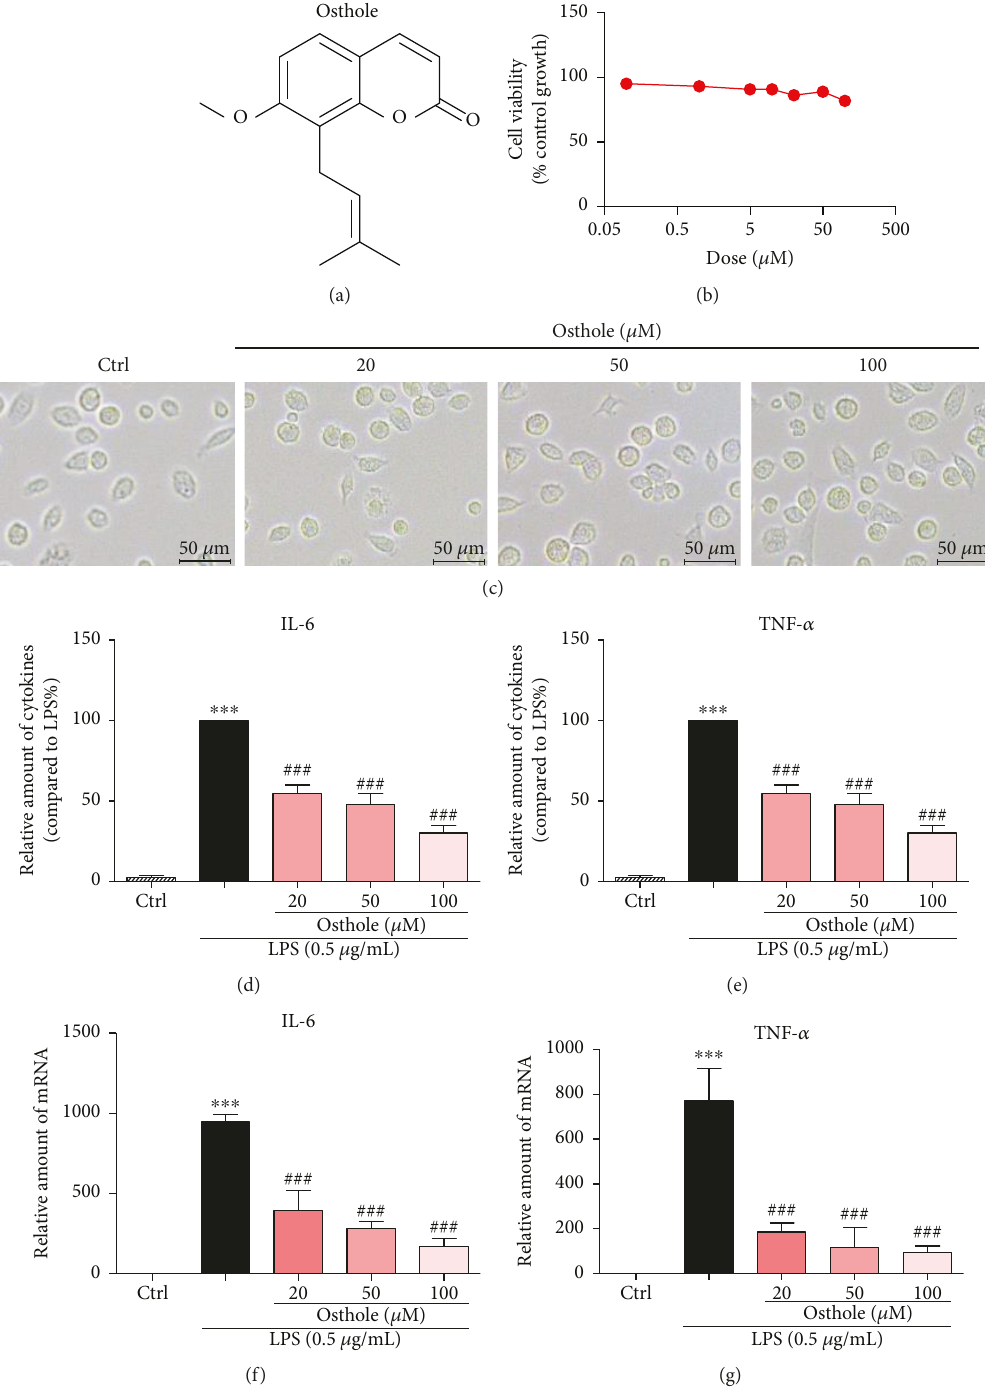
Figure 1: Osthole inhibits LPS-induced in fl ammatory cytokines in mouse peritoneal macrophages (MPMs). (a) The chemical structure of osthole. (b) MPMs were treated with various concentrations of osthole for 24 h. The viability of cells was measured by MTT assay and values reported as mean ± SEM ; n = 3 . (c) MPMs were treated with osthole (20, 50, or 100 μ M) for 24 h, and light micrographs were recorded using a microscope. Representative of three evaluations, n = 3 , micron bar = 20 μ m . (d – e) MPMs were pretreated with osthole (20, 50, or 100 μ M) for 0.5h and stimulated with LPS (0.5 μ g/mL) for 24h, and secreted IL-6 (d) and TNF- α (e) were measured from conditioned media by ELISA (Materials and Methods). Values normalized to total protein of cells and reported as mean ± SEM relative to LPS alone; n = 3 . (f – g) MPMs were pretreated with osthole (20, 50, or 100 μ M) for 0.5h and stimulated with LPS (0.5 μ g/mL) for 6h, and total RNA was extracted for real-time qPCR for IL-6 (f) and TNF- α (g). Values normalized to β -actin mRNA and reported as mean ± SE M ; n = 3 . (d – g) ∗∗∗ p < 0 001 versus control; ### p < 0 001 versus LPS